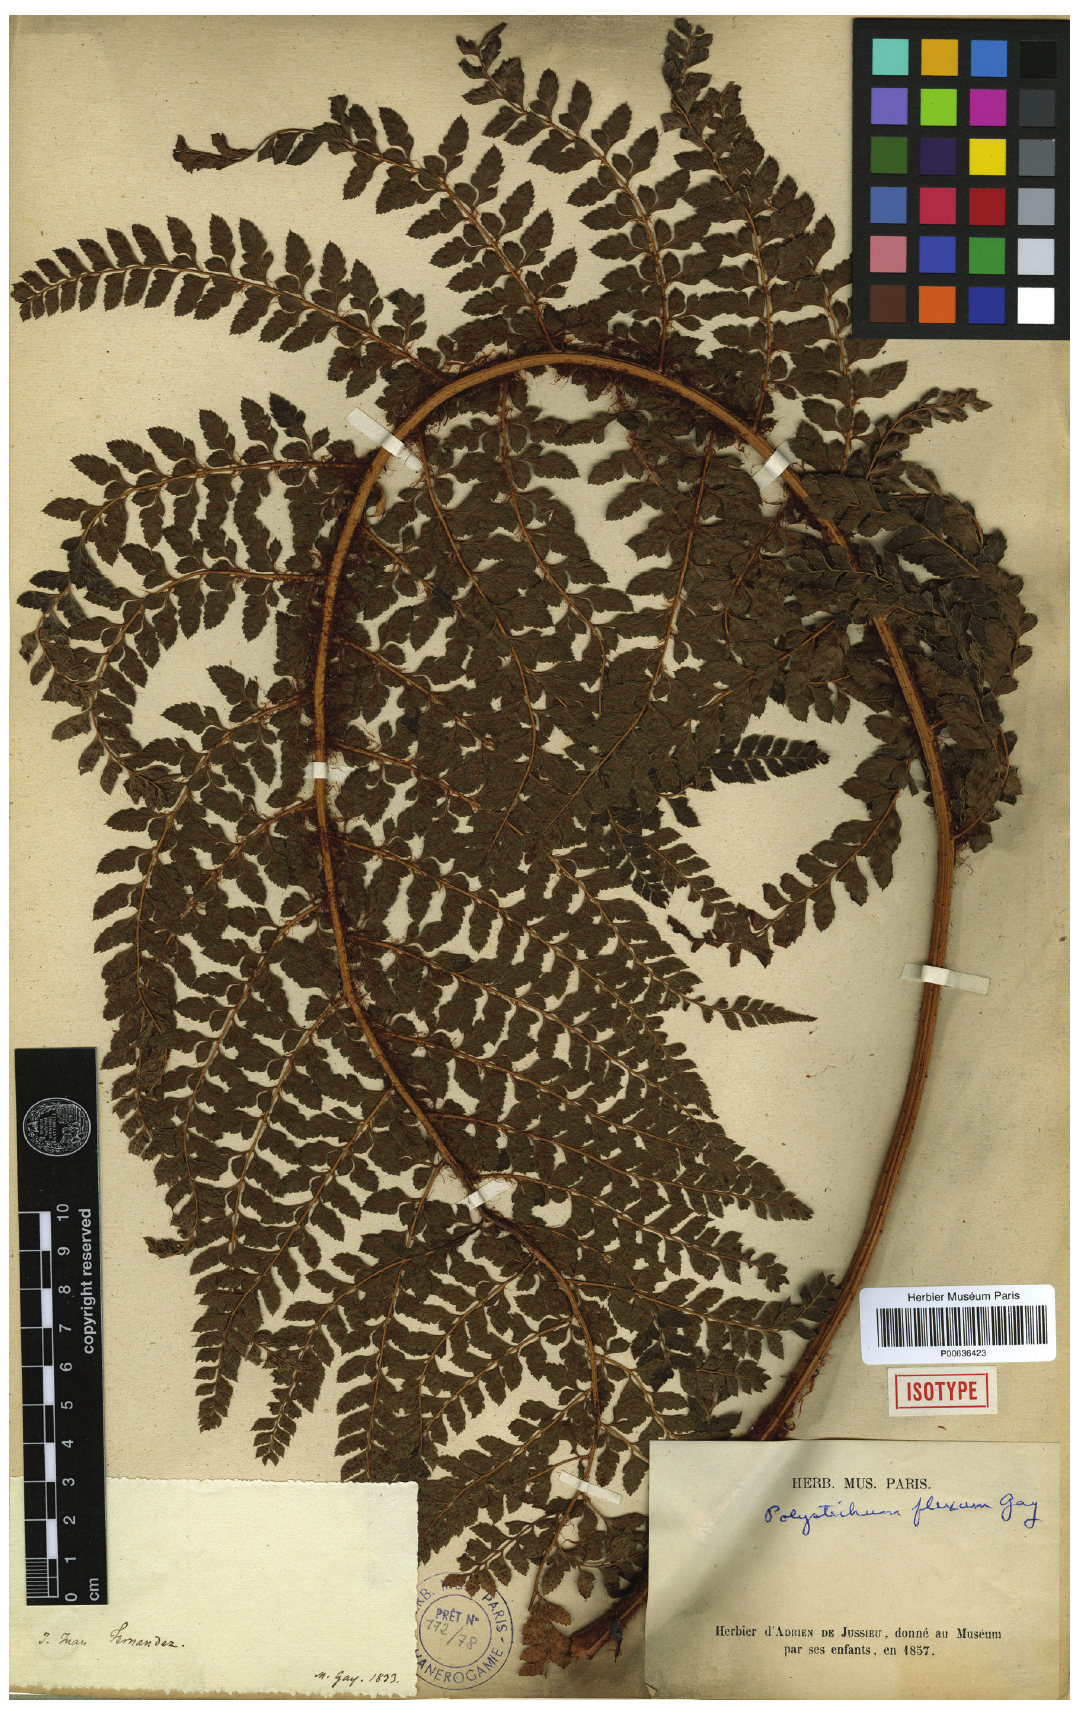
Figure 2: Polystichum flexum , collected by Gay in Juan Fernandez Island, Adrien de Jussieu collection, Muséum d’Histoire naturelle